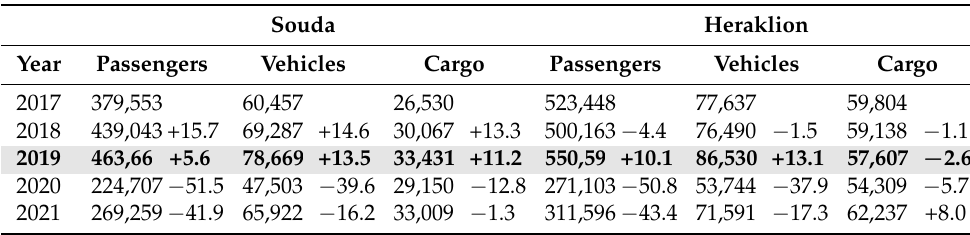
Table 1. Passenger ferries data variation compared to 2019. Souda Heraklion Vehicles